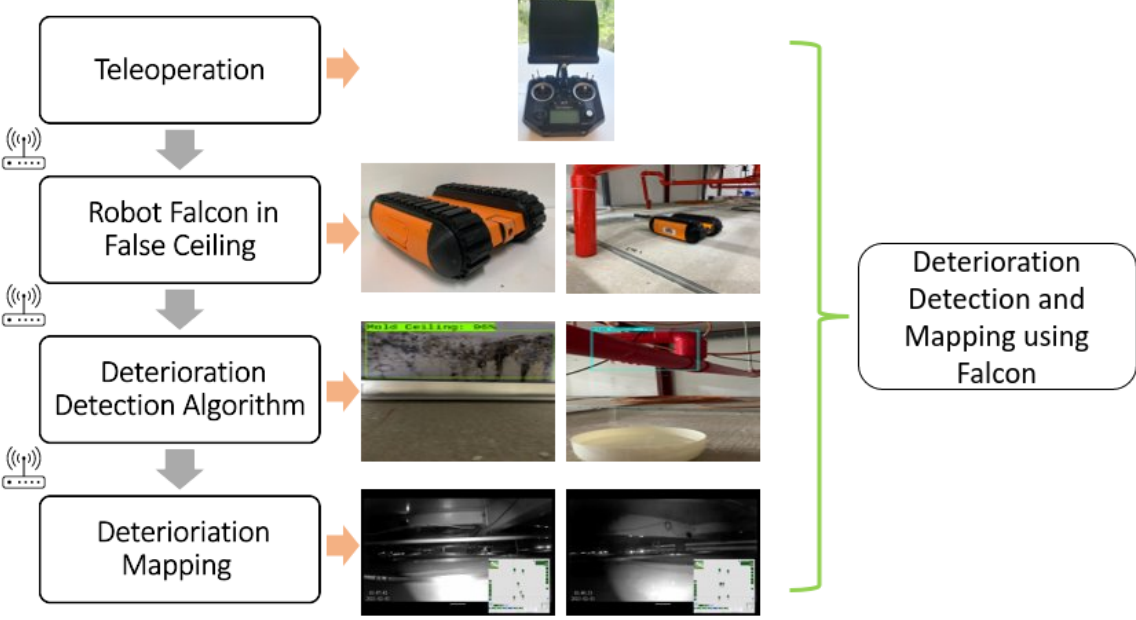
Figure 1. Overview of the proposed